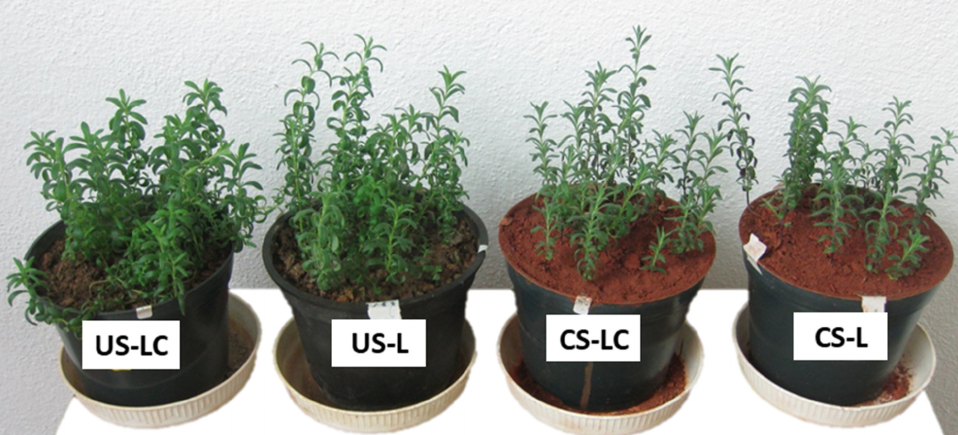
Figure 5. Hydrogen peroxide (H 2 O 2 ) contents in shoots of L. pedunculata grown from São Domingos seeds (LC) and Caldeirão seeds (L) planted in the contaminated soil from São Domingos (CS) and the uncontaminated soil from Caldeirão (US) (average ± standard error; n = 4). Different letters in- dicate significant differences among soil/plant treatments ( p < 0.05). DL: detection limit. The ascorbate and glutathione contents in leaves of L. pedunculata are shown in Figure 6. There were no significant differences for total ascorbate contents in L and LC in each soil, although there were significantly higher levels of total ascorbate in L and LC in CS compared to the plants from US (>3-fold higher) (Figure 6A). Furthermore, the percent- ages of reduced ascorbate (AsA) were much lower in L and LC growing in CS than in US (Figure 6A). Total glutathione contents were significantly lower in LC than in L in plants from US. These differences can be explained by changes in GSH levels, with L in US show- ing the highest levels and LC in US the lowest. This also led to the highest reduction state of glutathione (GSH) in US-L and the lowest in US-LC (Figure 6B).